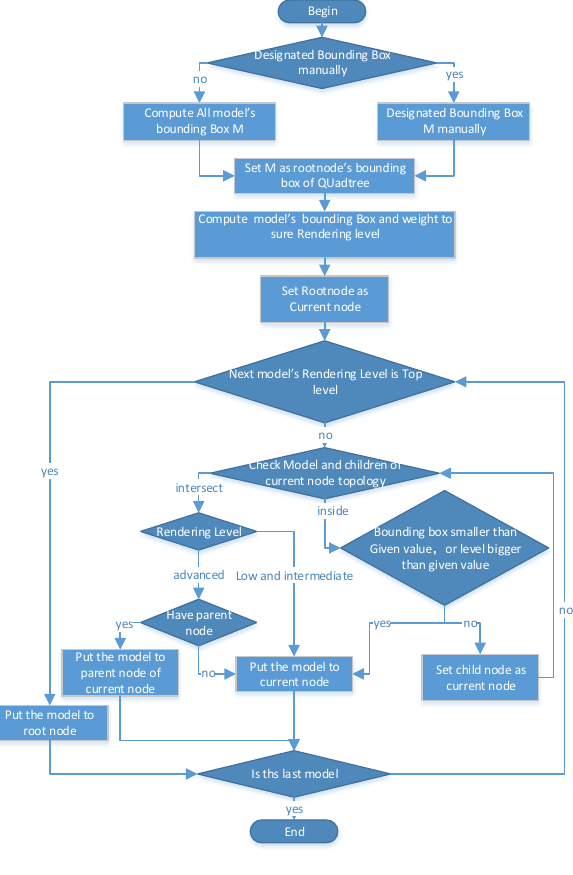
Figure 1. Quadtree construction